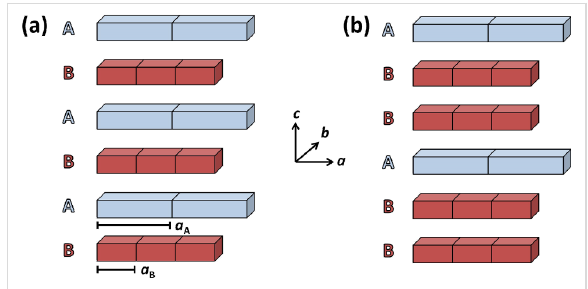
Figure 1: Schematic representation of two stacks of misfit compounds: (a) a misfit compound of type AB and (b) a misfit compound of type